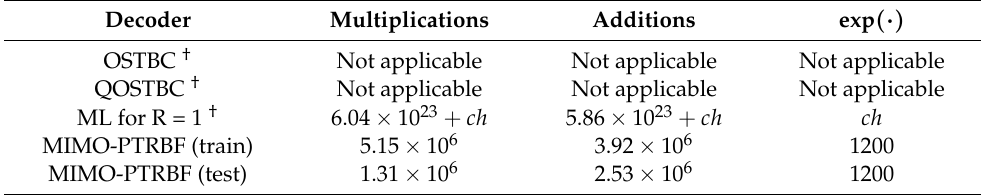
Table 5. Computational complexities for M T = M R = 32 and 2